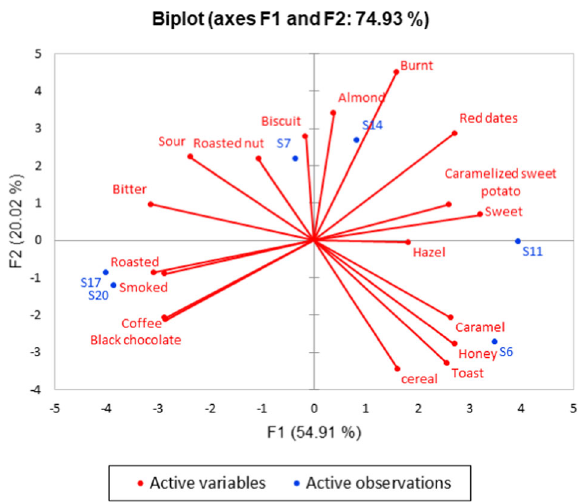
Fig. 2 Principal component analysis for six brewing malt samples. Correlations between 18 sensory attributes and specialty malts ( p <